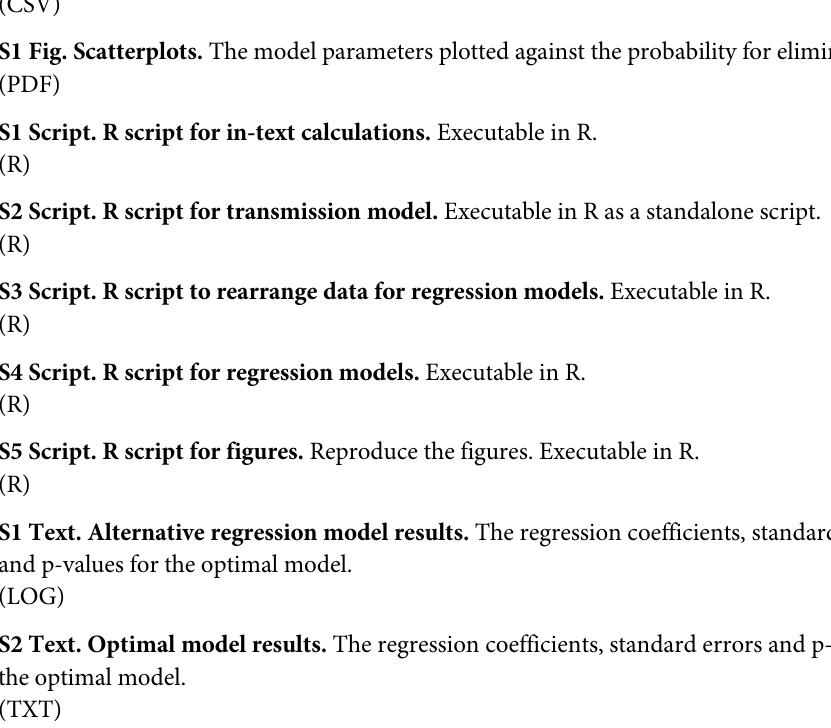
S1 Table. Excluded iterations. The parameter values for each excluded iteration due to popu- lation extinction events. S1 Fig. Scatterplots. The model parameters plotted against the probability for